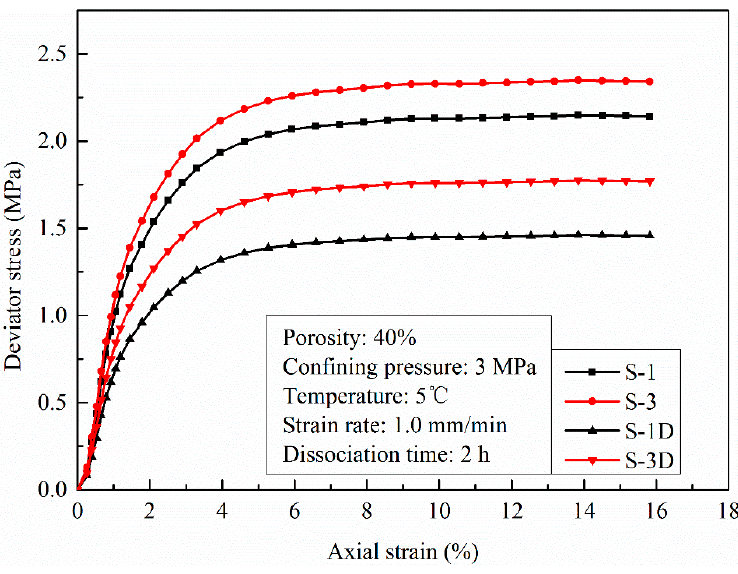
Figure 12. Stress–strain curves of HBMS formed by S-1 and S-3 marine sediments before and after hydrate dissociation.